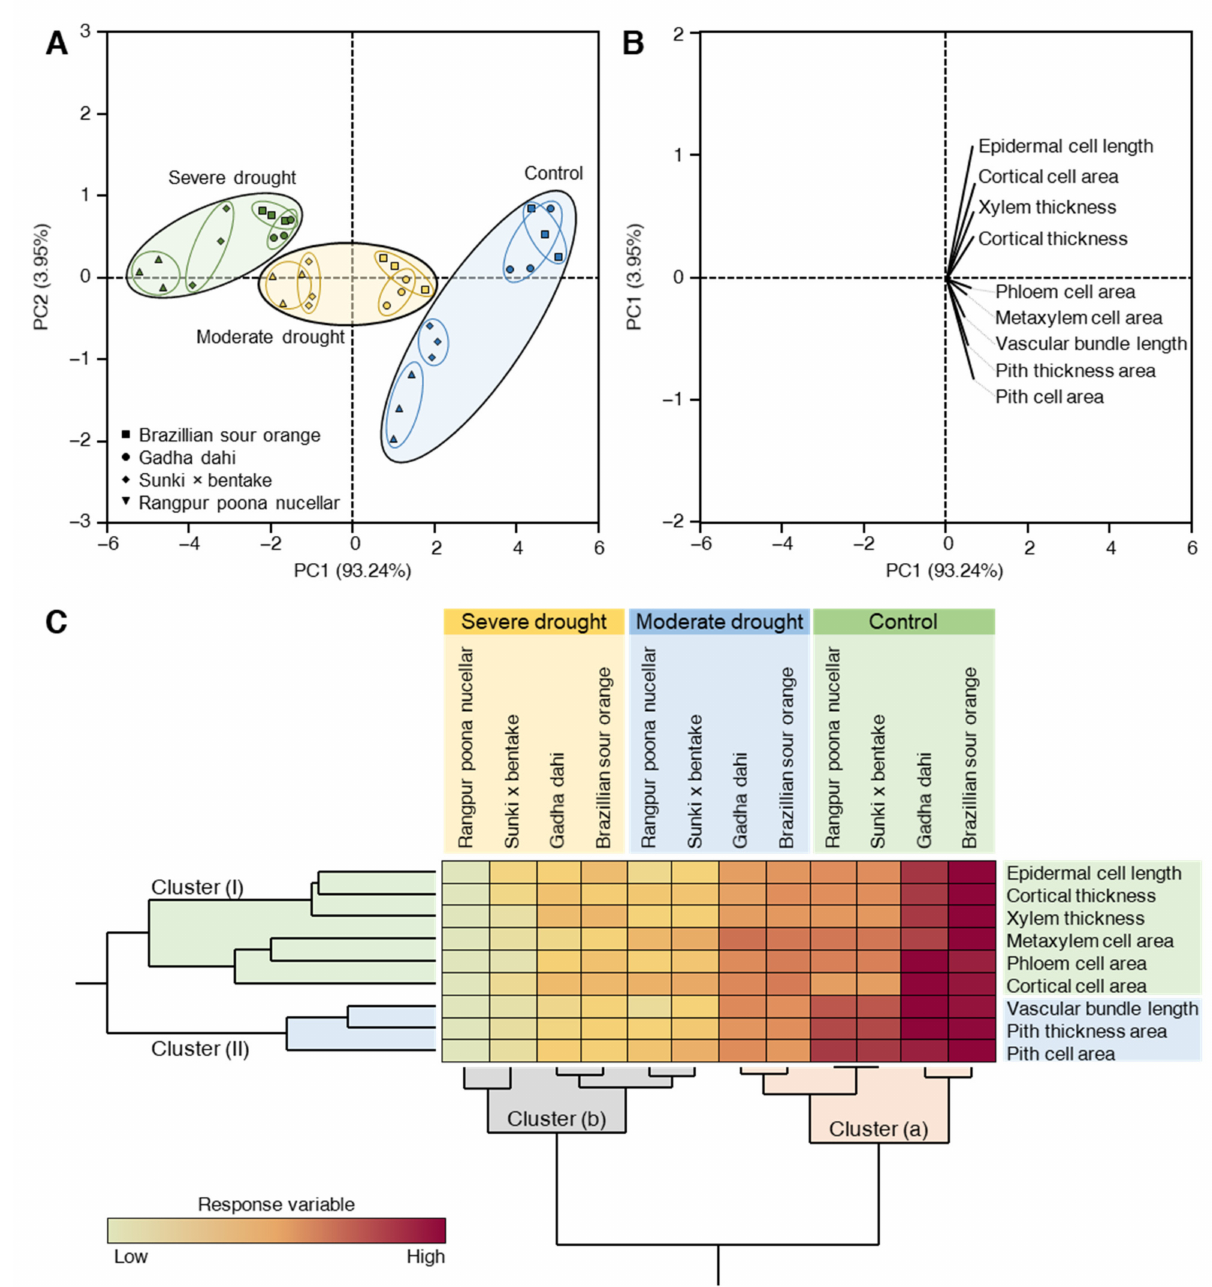
Figure 8. Principal component analysis (PCA) and two-way hierarchical cluster analysis (HCA) of individual leaf anatomical features of two highly tolerant (Brazilian sour orange and Gadha dahi) and two highly sensitive genotypes (Rangpur Poona nucellar and Sunki × bentake) under three water regimes. ( A ) PCA-associated scatter plots, ( B ) PCA-associated loading plots, and ( C ) two-way HCA. Variations in the dependent variables among studied treatments are visualized as a heat map. Rows correspond to dependent variables, whereas columns correspond to different treatments. Low numerical values are light-yellow-colored, while high numerical values are colored dark red (see the scale at the right bottom corner of the heat